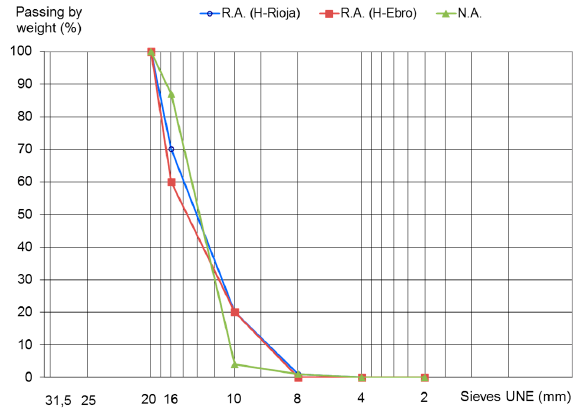
Figure 3. Grading of coarse aggregates utilized.